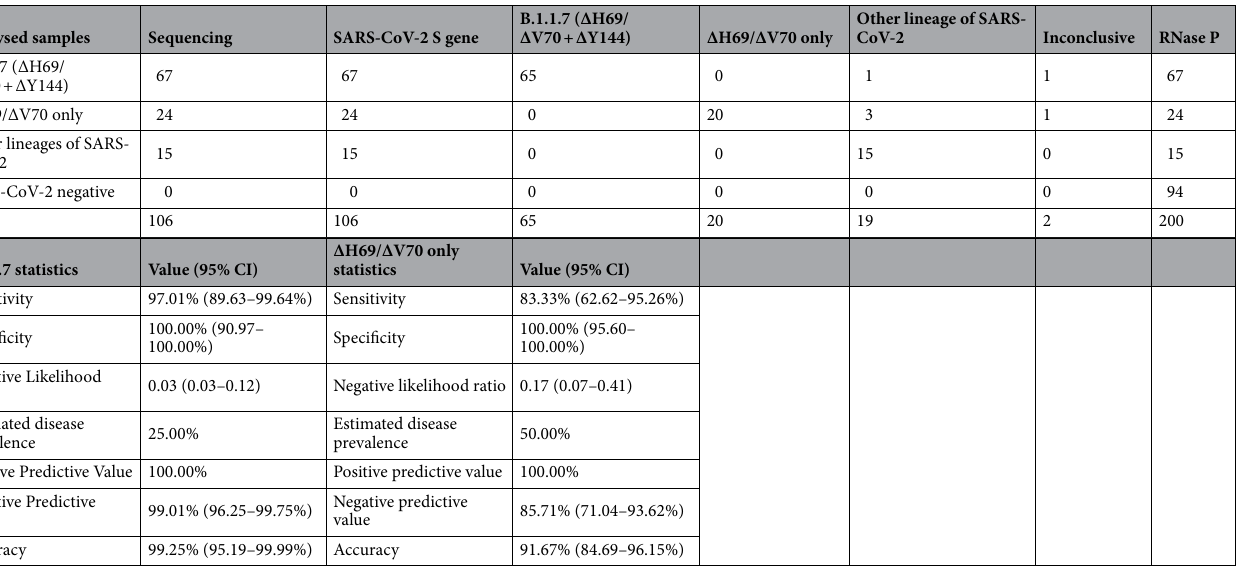
Table 3. Clinical performance of SARS-CoV-2 S gene and B.1.1.7 primer/probes